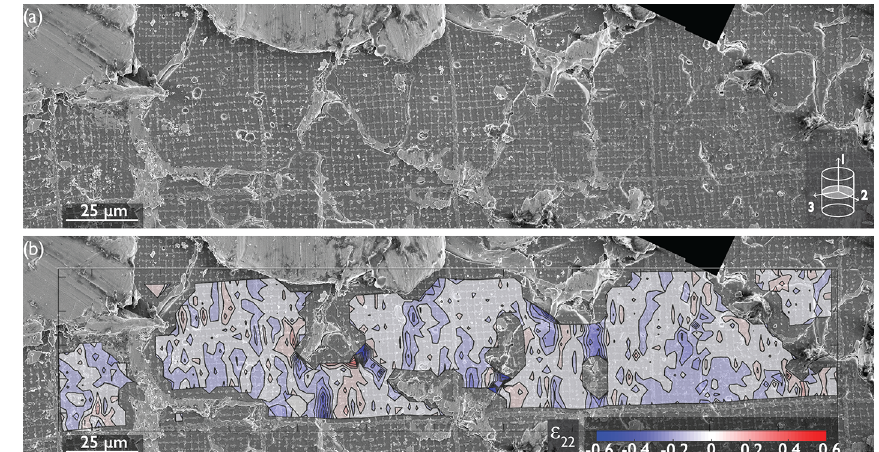
Figure 13. Strain inversion on a recovered grid in a fine-grained sample of San Carlos olivine deformed at T = 1100 ◦ C and P c = 300MPa to 5% deformation at 1 × 10 − 5 s − 1 . (a) Secondary electron image of the recovered area and (b) a superposed strain map of ε 22 , a component of the strain tensor that is perpendicular to the shortening direction.